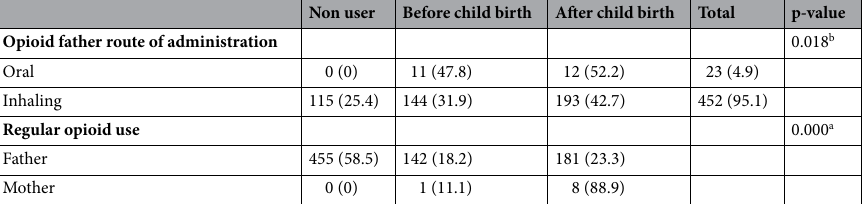
Table 2. Opioid consumption characteristics of the study population. Data are given as absolute number n (percentage). BMI: body mass index. a Fisher’s Exact Test. b χ 2